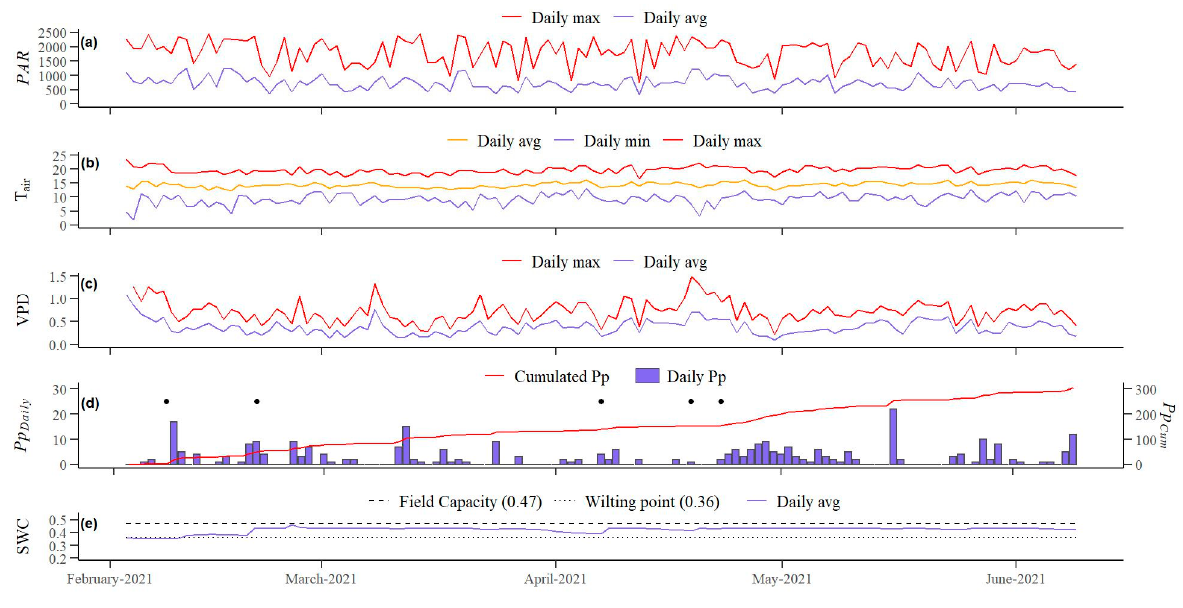
Figure 2. Meteorological variables observed along the experiment (from 3 February to 9 June 2021). ( a ) average and maximum daily photosynthetic active radiation (PPFD, µ mol (photon) m − 2 s − 1 ); ( b ) average, maximum, and minimum air temperature (Tair, °C); ( c ) average and maximum daily vapor pressure deficit (VPD, kPa); ( d ) daily and cumulated precipitation (Pp, mm), shown as daily sum, black dots indicate irrigation times; ( e ) soil water content, (SWC, cm 3 cm − 3 ), measured at 0–20 cm depth, shown as daily mean values.